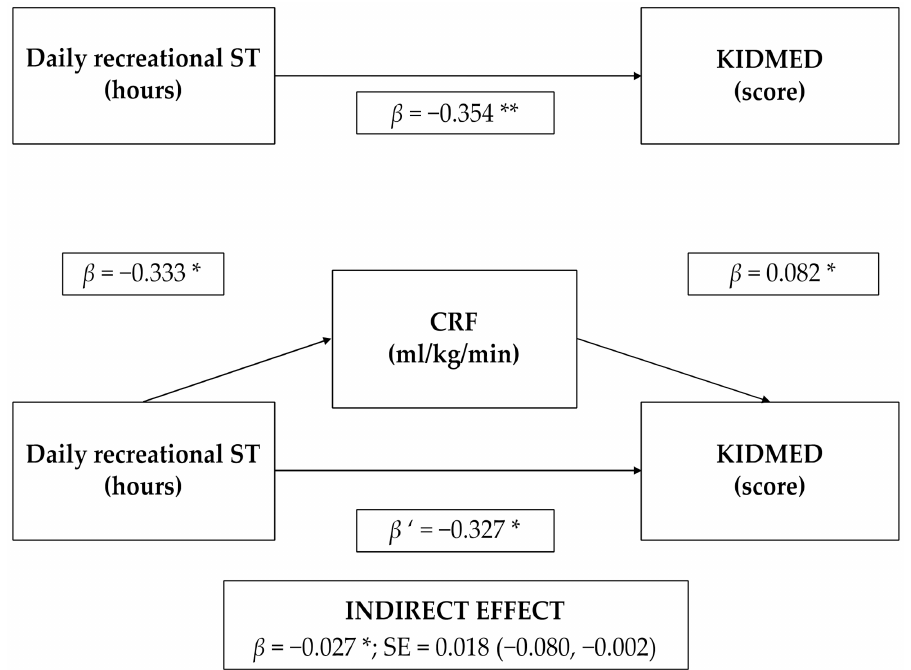
Figure 2. Cardiorespiratory fitness mediation model of the relationship between recreational screen time and adherence to the Mediterranean Diet in schoolchildren. CRF, cardiorespiratory fitness; ST, screen time. Adjusted by sex, age, type of schooling, area of residence, and body fat percentage. * p < 0.050; ** p <